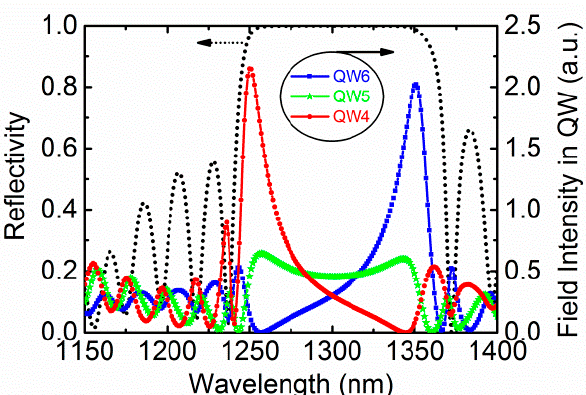
Figure 4. Simulated reflectivity as well as field intensity spectra in QD layers (QD#4, #5 and #6). The incident electric field is normalized to unity.